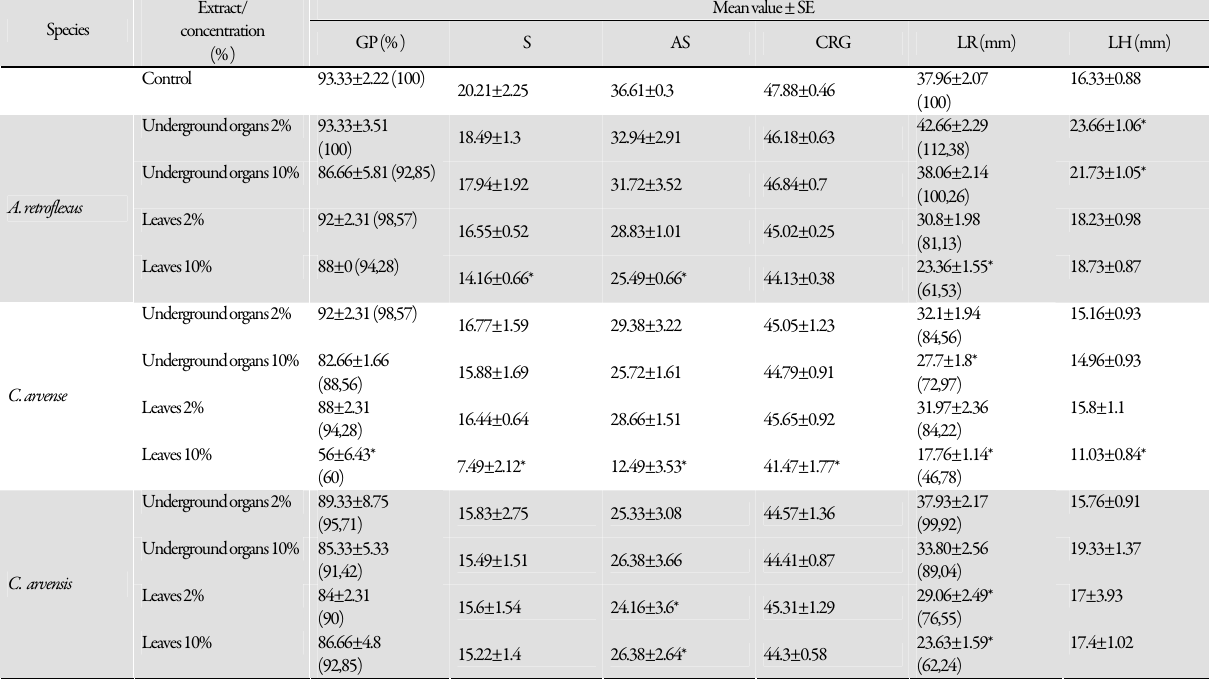
Table 1. Effect of aqueous extracts of dicotyledonous weeds on the analyzed